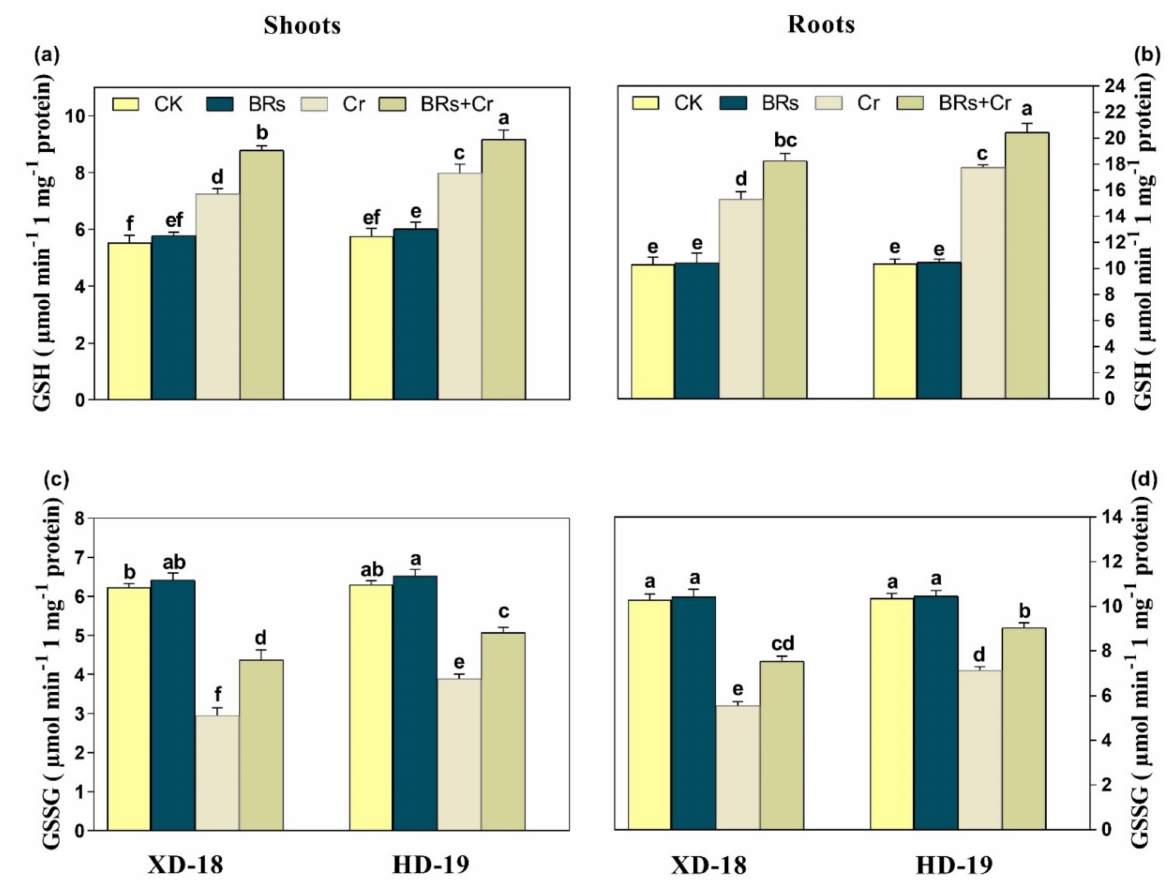
Figure 8. Effects of foliar-applied BRs on the activities of ( a ) GSH in shoots, ( b ) GSH in roots, ( c ) GSSG in shoots, and ( d ) GSSG in the roots of both soybean genotypes (XD-18 and HD-19) under chromium (Cr) (0, and 100 µ M) stress. Values are the means ± SD of four independent replicates. Different alphabetical letters on bars indicate significant differences among the treatments ( p < 0.05) by the least significant difference